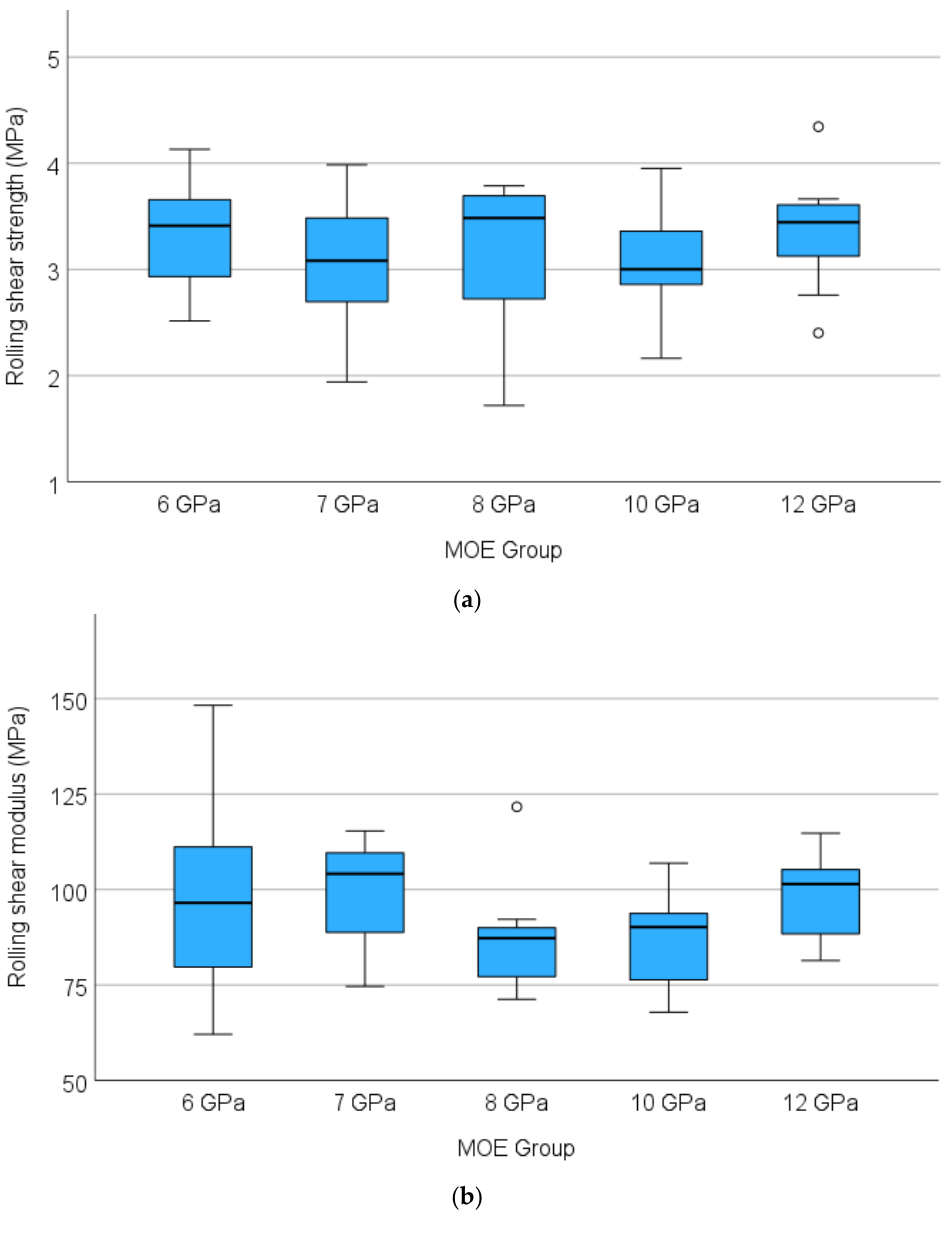
Figure 7. Rolling shear properties for various MOE groups, ( a ) rolling shear strength, ( b ) rolling shear modulus (southern